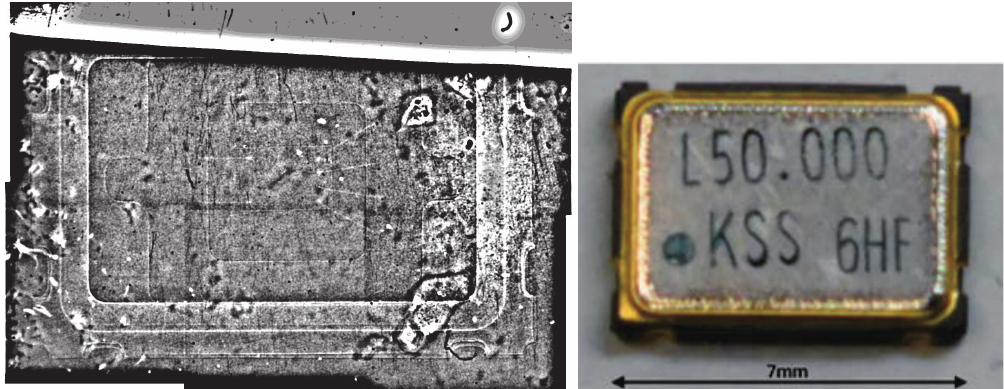
Figure 9. ( left ) Bandpass filter applied to the quartz crystal oscillator image. The vertical axis of the neutron beam corresponds to the horizontal axis of the oscillator image. ( right ) Photographic image of the quartz crystal